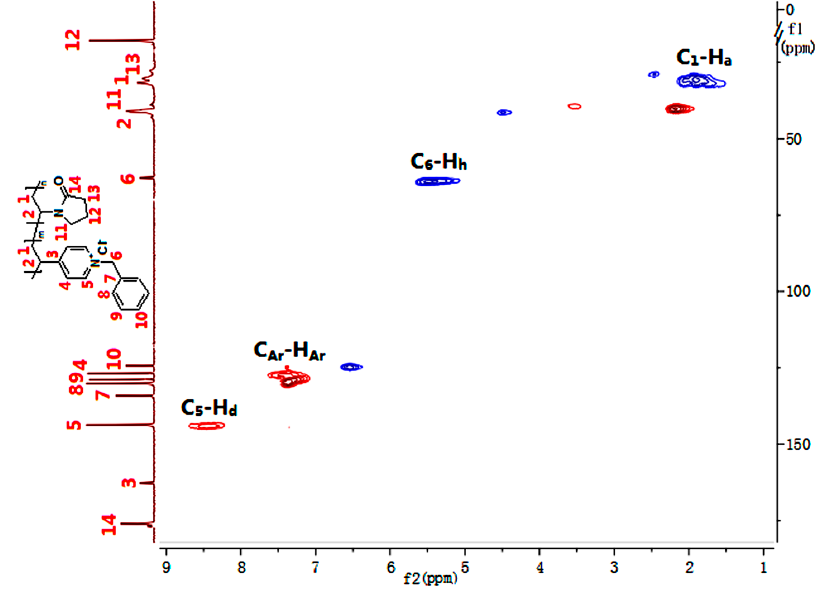
Figure 3. 13 C NMR and 2D NMR ( 13 C– 1 H HSQC NMR) spectra of poly(BVPC- co -NVP) in D 2 O.